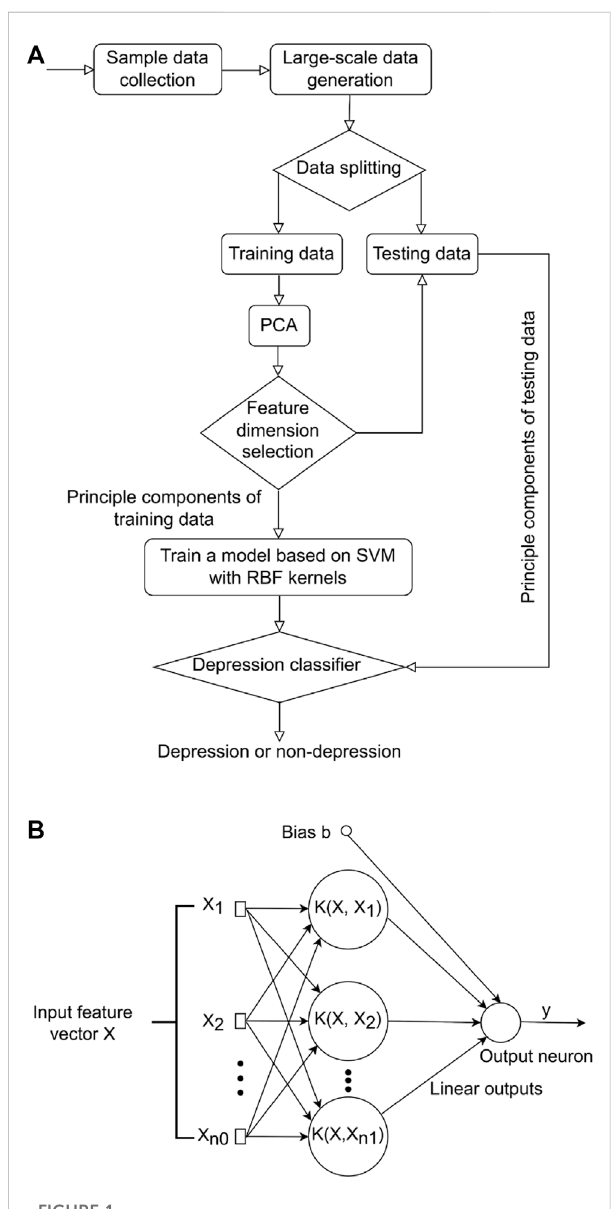
FIGURE 1 Overview of study methodology. (A) Flowchart of the proposed method for differentiating between those with major depression from those without in FMS patients. (B) Flowchart of SVM model. FMS, Fibromyalgia syndrome; SVM, support vector